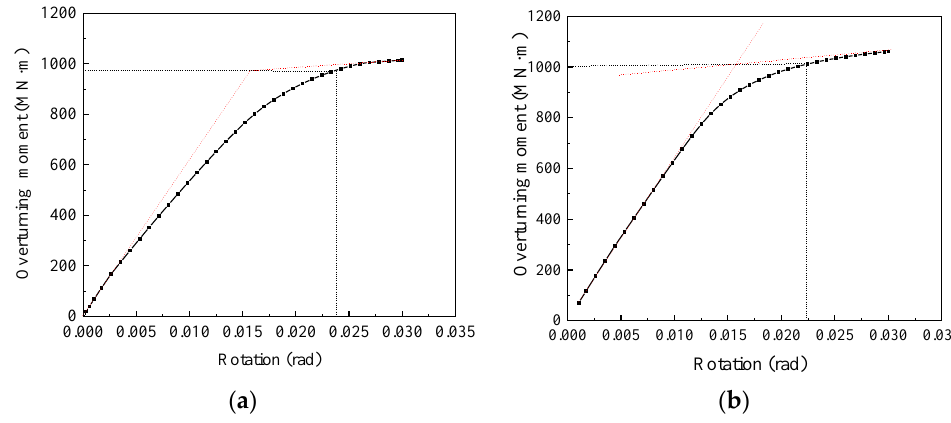
Figure 19. Overturning moment-rotation plot for the TSPJF and TBJF. ( a ) TSPJF, ( b ) TBJF.